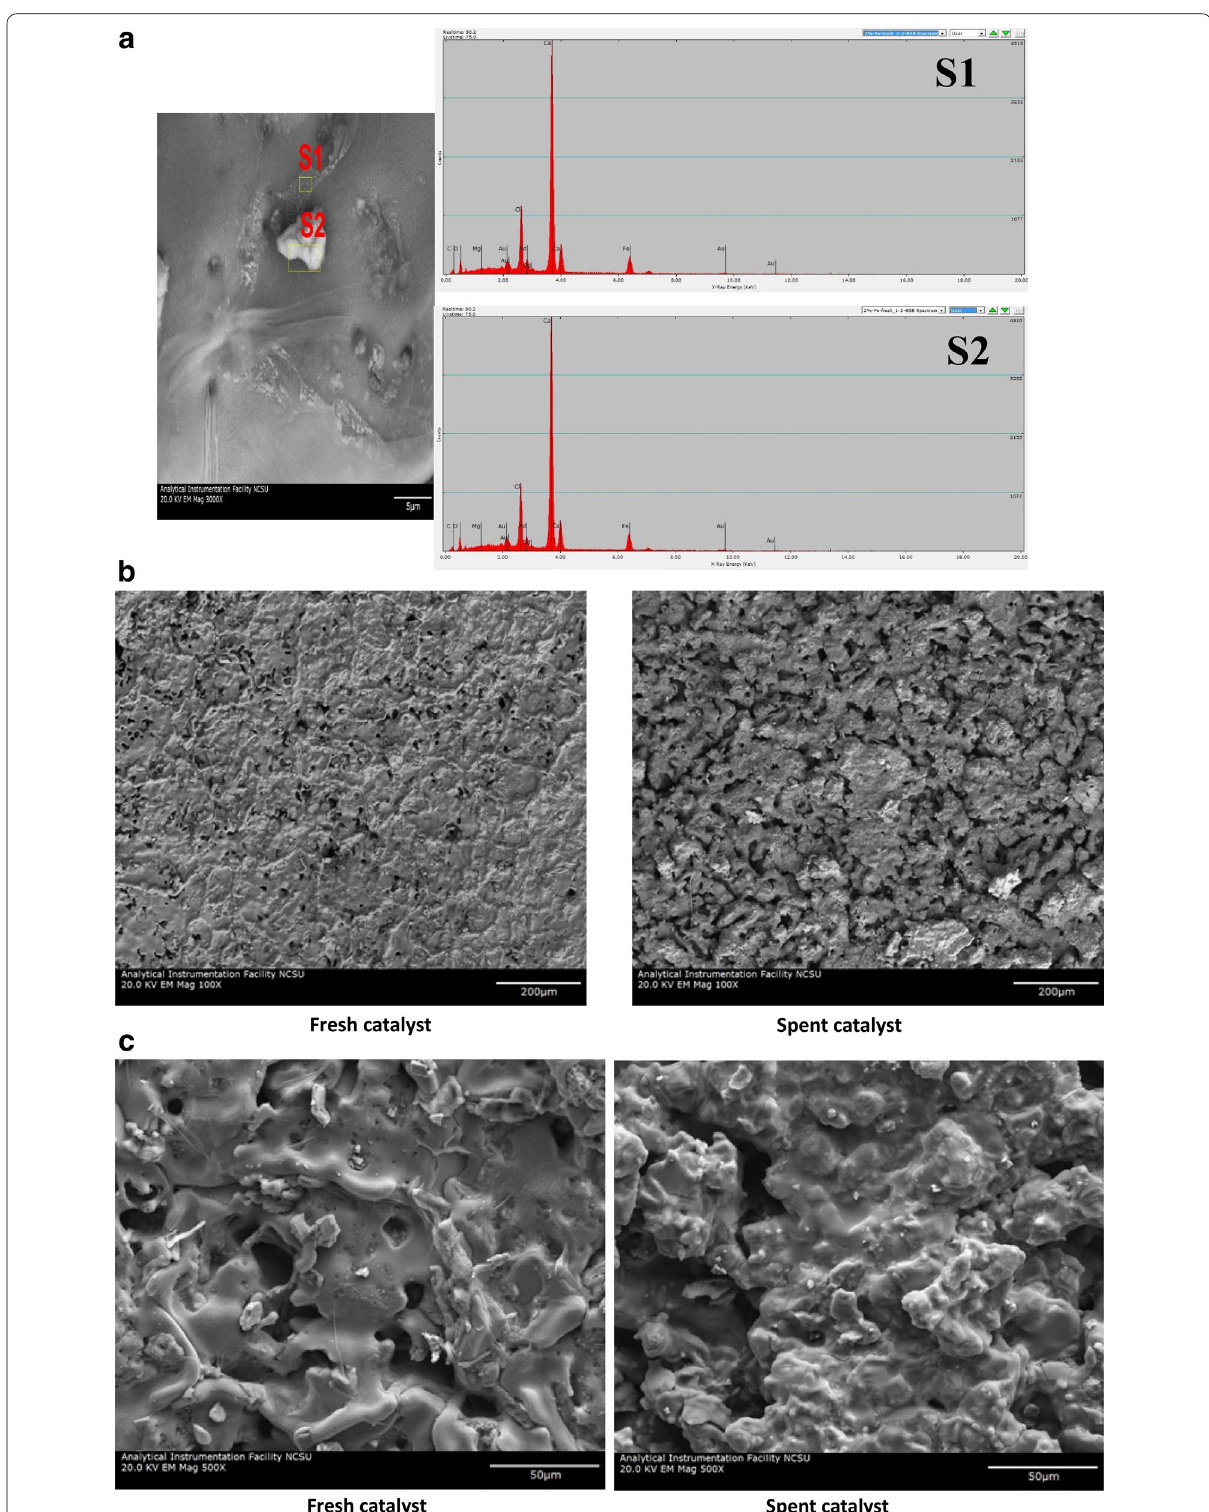
Fig. 2 VPSEM analysis for 2% Fe-loaded eggshell catalyst: a 2% Fe-loaded fresh catalyst representing heterogeneous surface with multiple active sites; b , c - 2% Fe-loaded fresh and spent catalyst representing change in overall surface